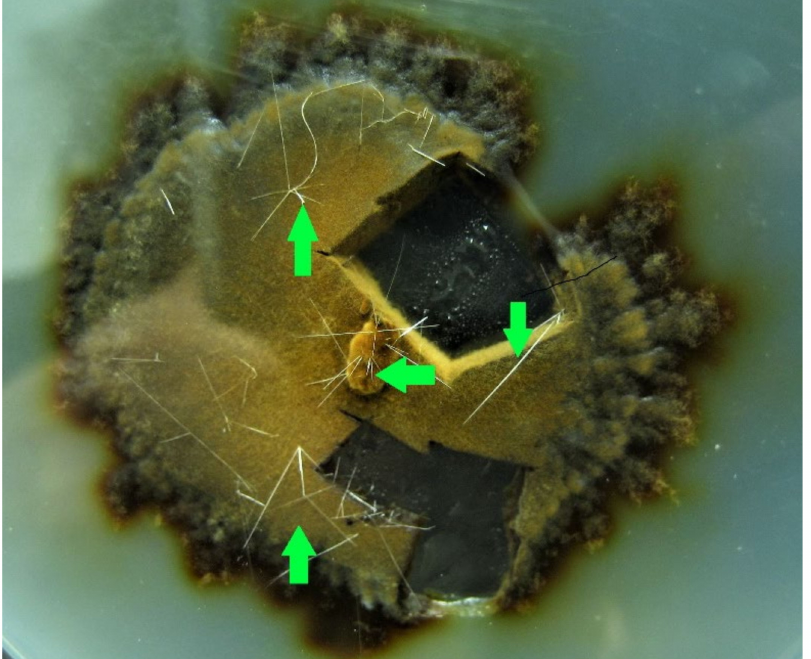
Figure 6. Pure culture of Phylloporia ribis showing white 1 cm-long crystals, a number of which are indicated by the green